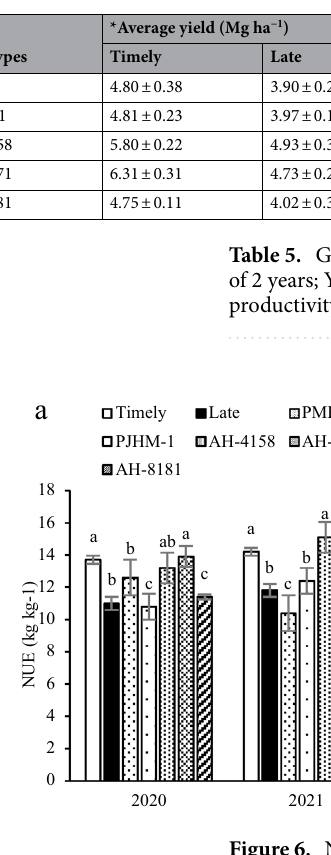
Figure 6. NUE- nitrogen use efficiency ( a ), PUE- phosphorus use efficiency ( b ), KUE- potassium use ( c ). Within years, sowing time, and genotypes, different letters indicate significant difference ( p ≤ 0.05).